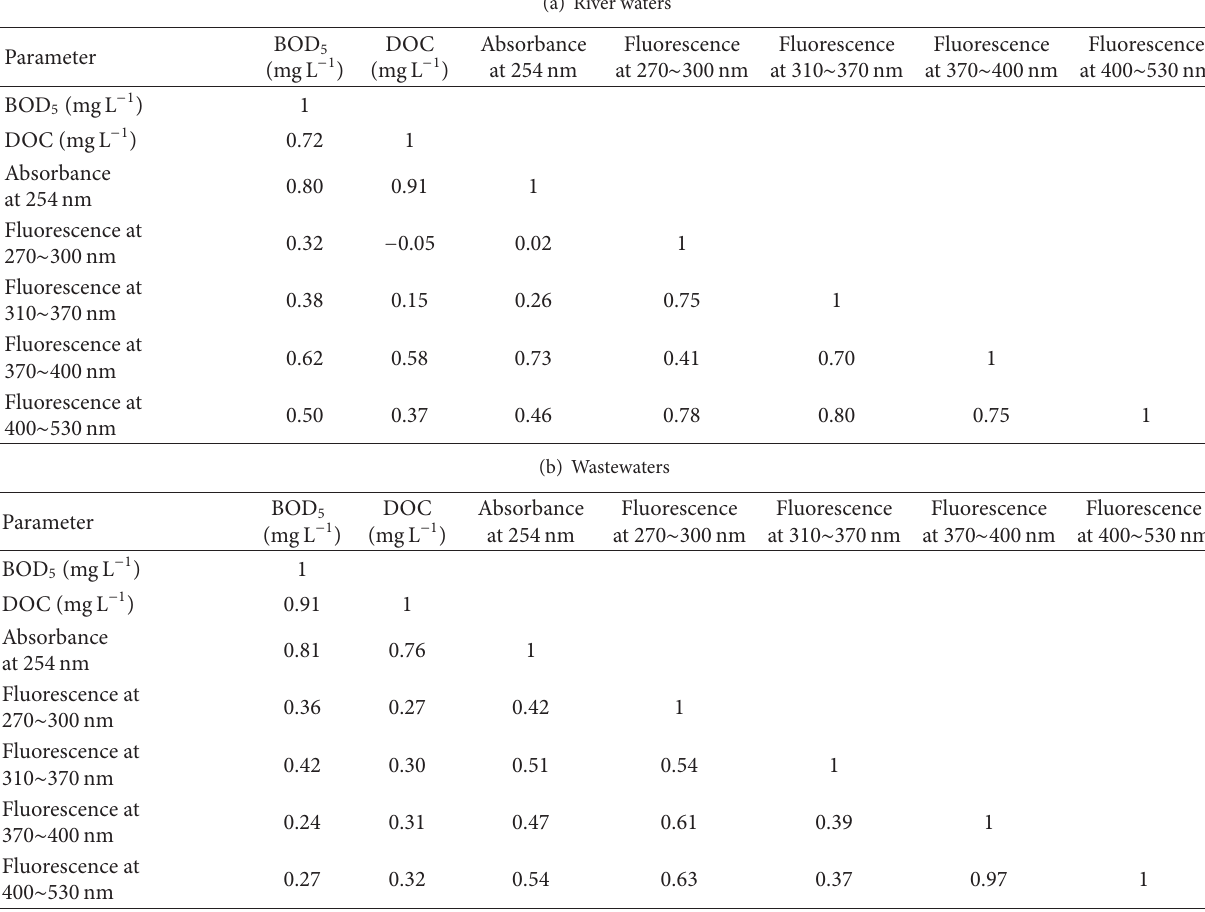
T 2: Correlation coefficients between parameters for (a) river waters and (b)